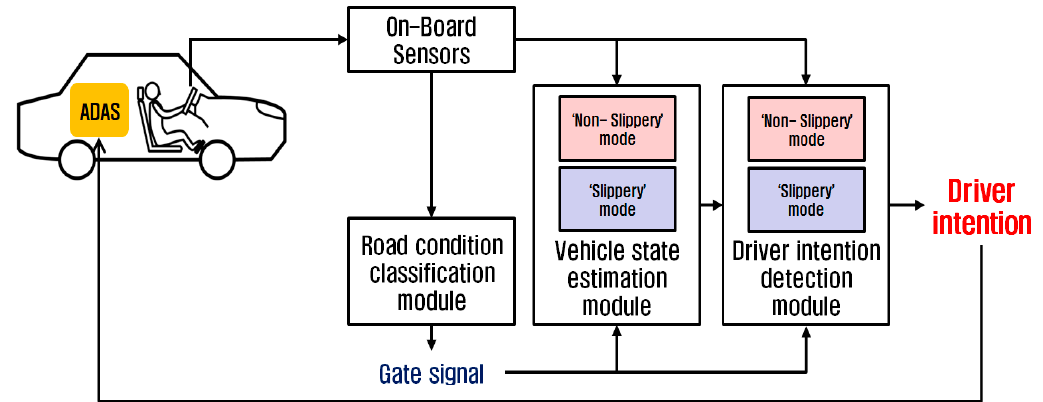
Figure 1. A schematic diagram of the system developed for driver intention classification.